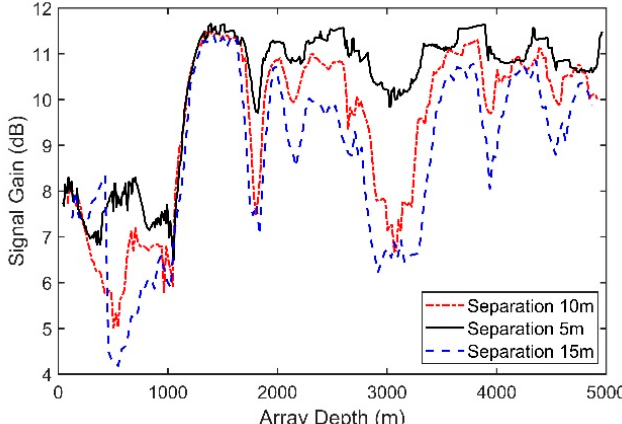
Figure 9. SG with different array locations for the sources at the depths of ( a ) 50 m, ( b ) 100 m and ( c ) 200 m.